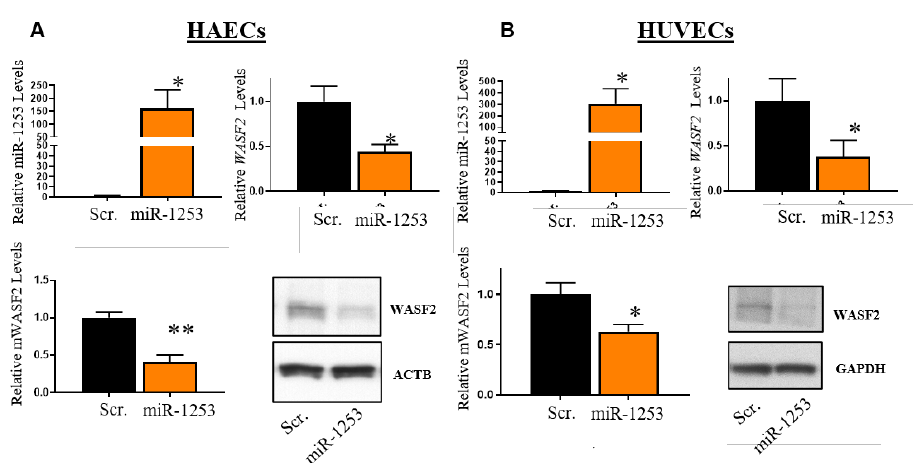
Figure 4. Overexpression of miR-1253 in HAECs and HUVECs reduces expression of WASF2. The 50 nM miR-1253 was transfected into HAECs ( n = 3) ( A ) and HUVECs ( n = 5) ( B ) for 48 h, and overexpressed in each cell line compared with a scrambled negative control mimic (scr.; top left). WASF2 mRNA expression was normalized to GAPDH in each cell line and shown relative to a scrambled control (scr.; top right). WASF2 proteins levels were normalized to β actin (HAECs) or GAPDH (HUVECs) and shown relative to a scrambled control (scr.; bottom left). Representative immunoblots are shown for WASF2 and loading controls in each cell line (bottom right); * p < 0.05, ** p < 0.01, by one-tailed T-test (for confirmation of miR-1253 and mRNA expression levels in each cell line) or two-tailed student’s T-test for all protein levels. Columns represent the mean ± S.D.